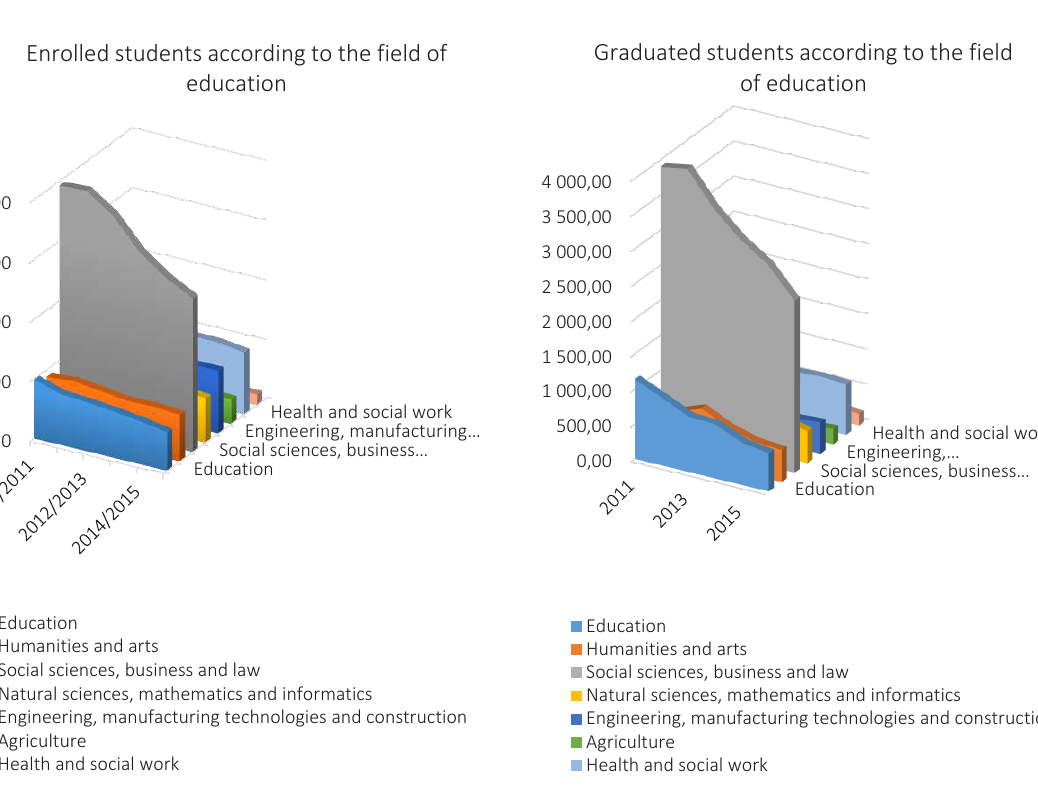
Figure 3. Enrolled and graduated students according to the field of